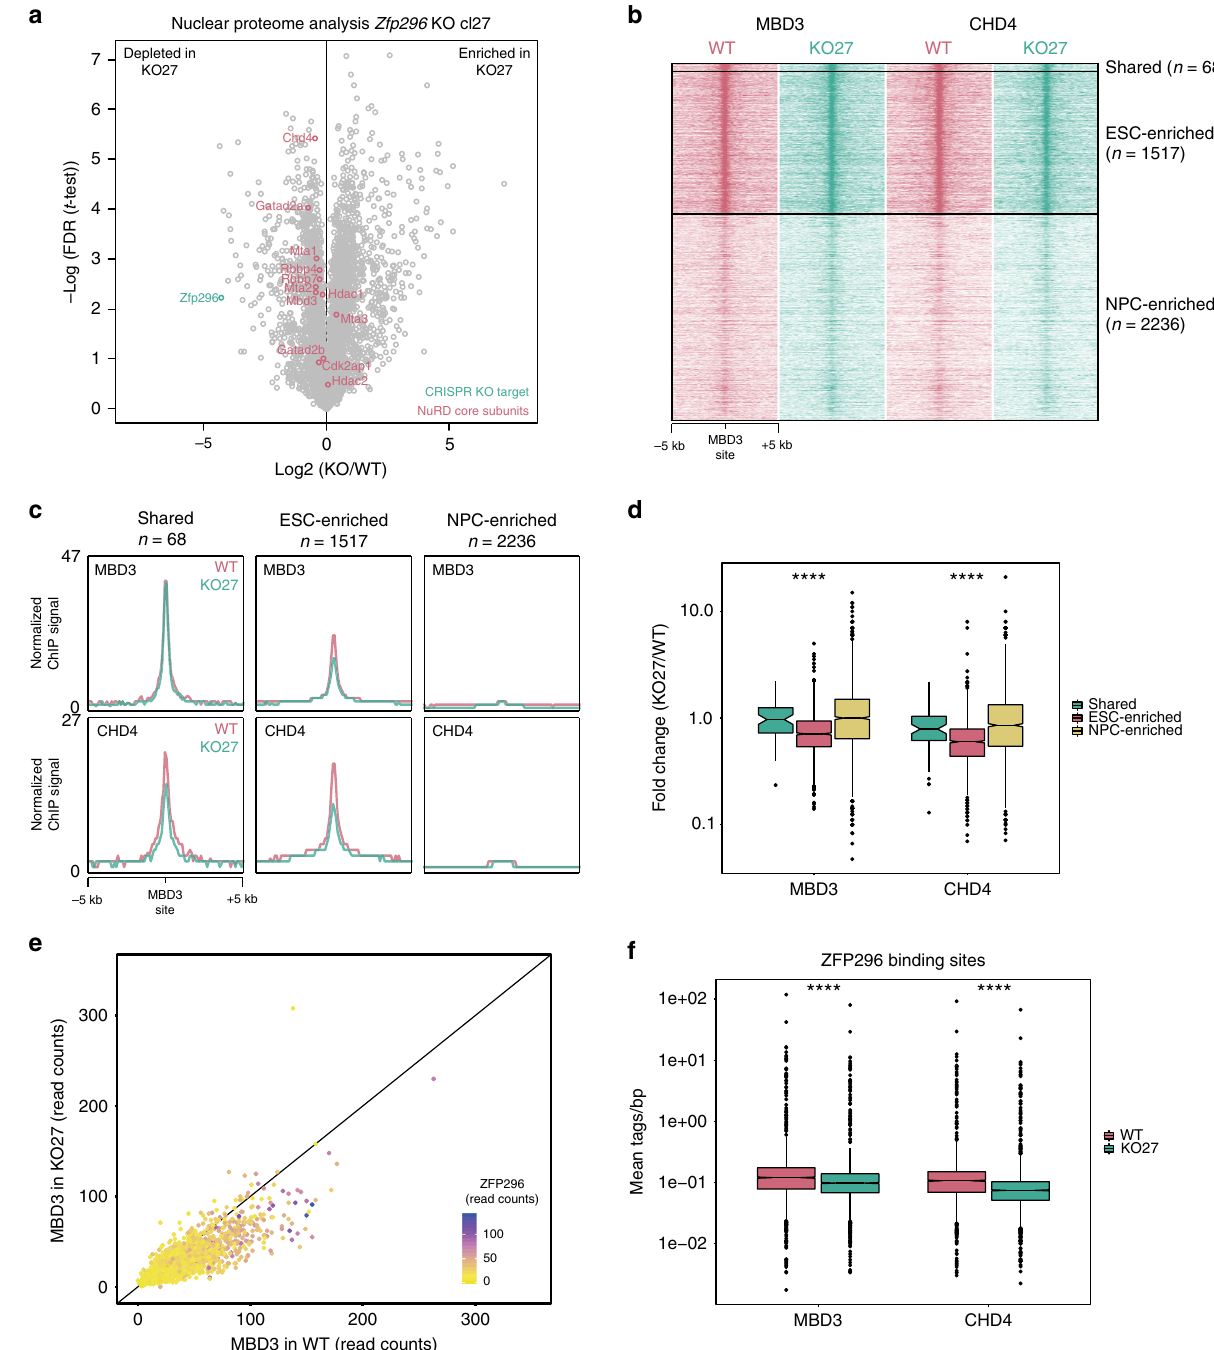
Fig. 4 ZFP296 knockout decreases NuRD binding genome-wide. a Volcano plot from label-free whole proteome mass spectrometry analysis of WT and Zfp296 KO clone 27 ESCs, graphed as in Fig. 2a. The CRISPR KO target Zfp296 is colour-coded in green, NuRD core subunits are colour-coded in red. b Heat map showing the ChIP-seq read density for MBD3 and CHD4 in WT and Zfp296 KO clone 27 ESCs, centred on the union of MBD3 peaks from ESC and NPC. c Band plots of MBD3 and CHD4 ChIP-seq in WT and Zfp296 KO clone 27 ESCs at MBD3 binding sites for each class of NuRD binding. d Fold change in ChIP-seq read counts ( Zfp296 KO clone 27/WT) of MBD3 and CHD4 at MBD3 binding sites for each class of NuRD binding. Box: median (central line), fi rst and third quartile (box limits); whiskers: 1.5 × interquartile range. **** p < 0.0001, as assessed by ANOVA. e Scatterplot of MBD3 ChIP- seq read counts at ESC-enriched MBD3 binding sites in WT and Zfp296 KO clone 27 ESCs, coloured for the amount of ZFP296 at the same locus. The diagonal line indicates no change between the two conditions. A linear model on these data performs signi fi cantly better when taking into account ZFP296 levels as a predictive variable ( p < 0.001, as assessed by ANOVA). f Boxplots of average MBD3 and CHD4 ChIP-seq signal in WT and Zfp296 KO clone 27 ESCs at all GFP-ZFP296 peaks. Box: median (central line), fi rst and third quartile (box limits); whiskers: 1.5 × interquartile range. ****p < 0.0001, as assessed by Kruskal – Wallis test. See also Supplementary Fig.